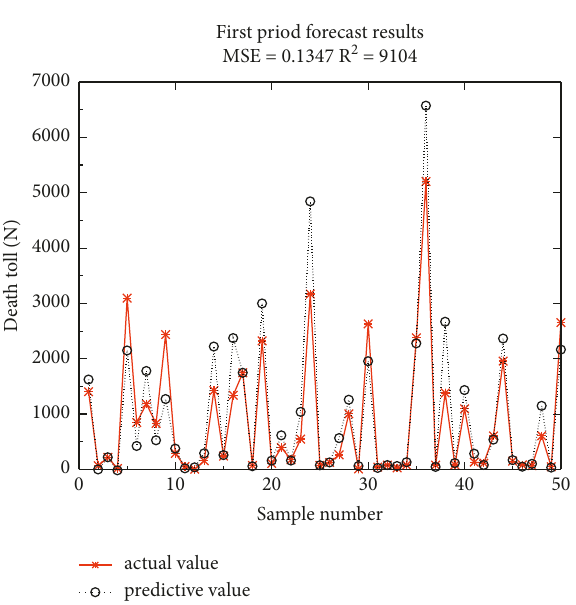
Figure 5: Prediction results in the first rolling